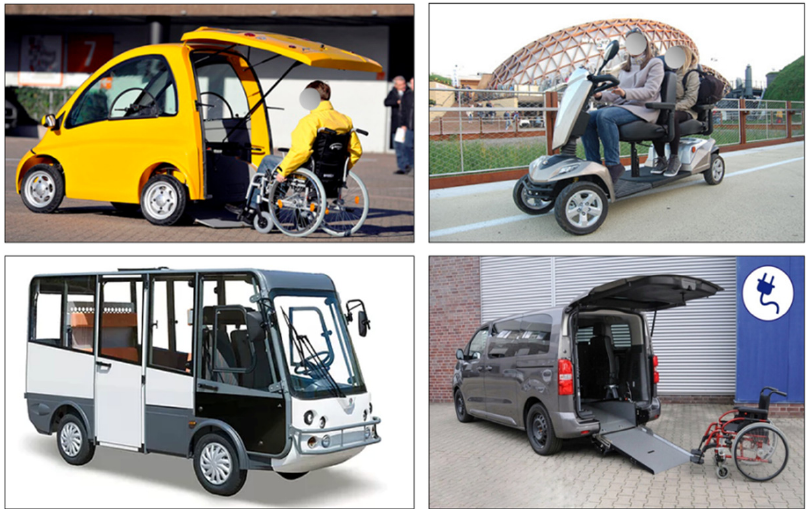
Figure 1. EV typologies for transportation of people with disabilities.